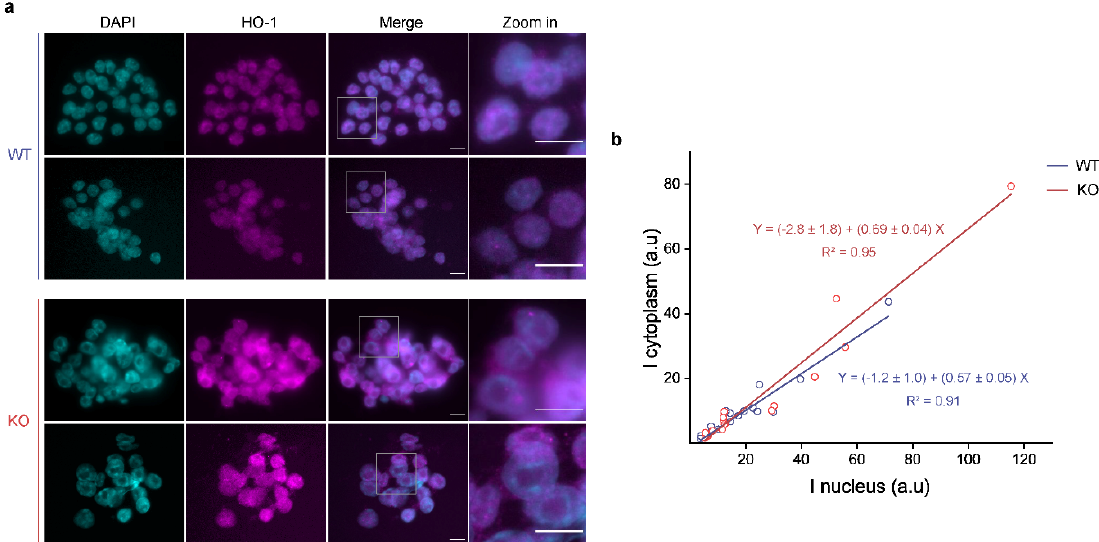
Figure 4. p53 KO ES cells exhibit higher HO-1 cytoplasmic levels. Wild type (WT) and p53 KO ES cells were cultured under standard conditions and HO-1 protein levels were analyzed by immunofluorescence. ( a ) Representative fluorescence microscopy images of WT and KO ES cells. Scale bars: 10 μ m. ( b ) HO-1 immunofluorescence intensity of nuclei vs. cytoplasm for WT (blue) or KO (red) ES cells. The equations shown in the figure were obtained by a linear fit of the data, with a statistical weight corresponding to the number of cells in each field.